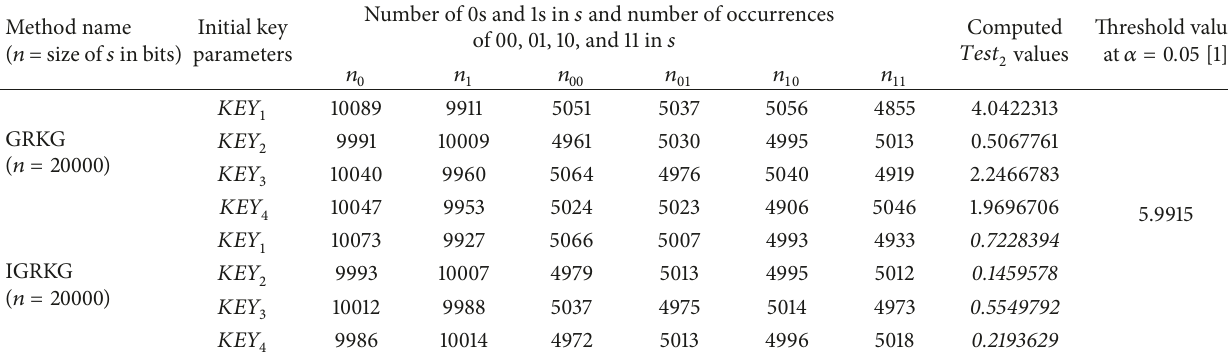
Table 8: 𝑇𝑒𝑠𝑡 2 values for a binary sequence 𝑠 of size 𝑛 = 20000 , where 𝑠 is generated individually from both the GRKG and the IGRKG generators corresponding to four different input 𝐾𝐸𝑌 parameters that have been mentioned in Table